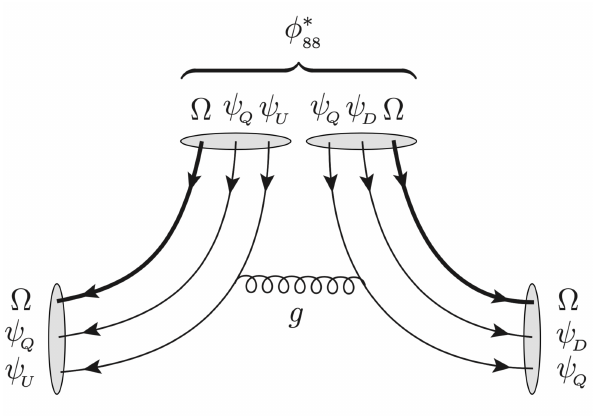
Figure 2 . Yukawa coupling of the weak-doublet Vlepton of components Ω (1 , 2) composite scalar φ